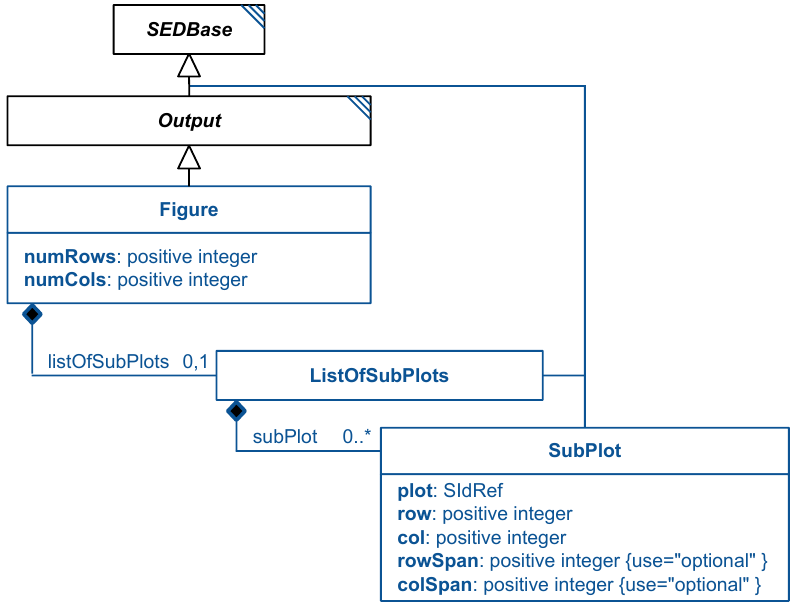
Figure 2.26: The definition of the SED-ML Figure, ListOfSubPlots, and SubPlot classes.